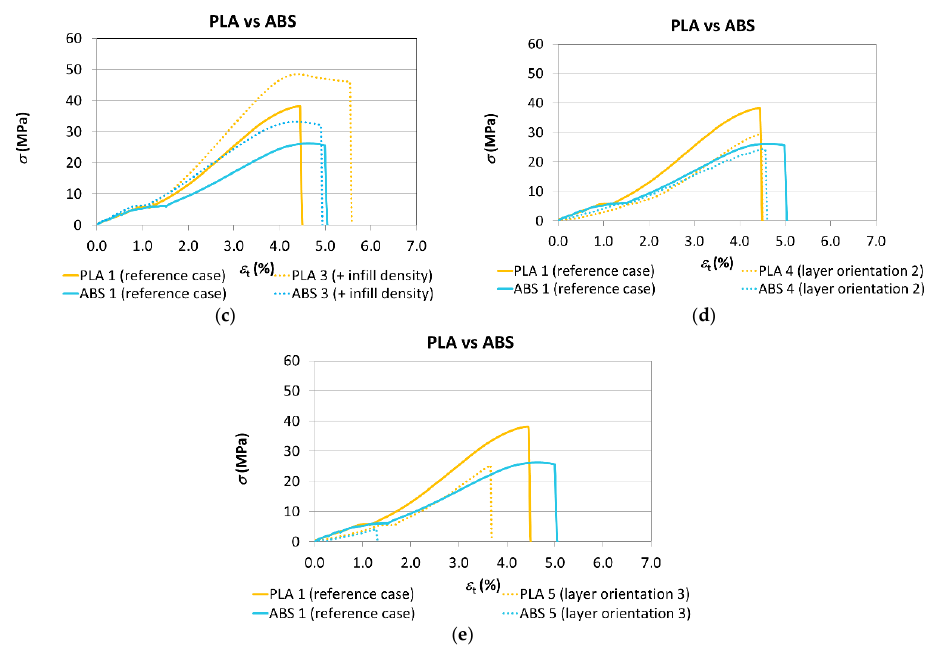
Figure 12. The comparison of the stress – strain curves for both materials. ( a ) Filaments vs. Reference case, ( b ) Reference case vs. + layer height, ( c ) Reference case vs. + infill density, ( d ) Reference case vs. layer orientation 2, ( e ) Reference case vs. layer orientation 3.